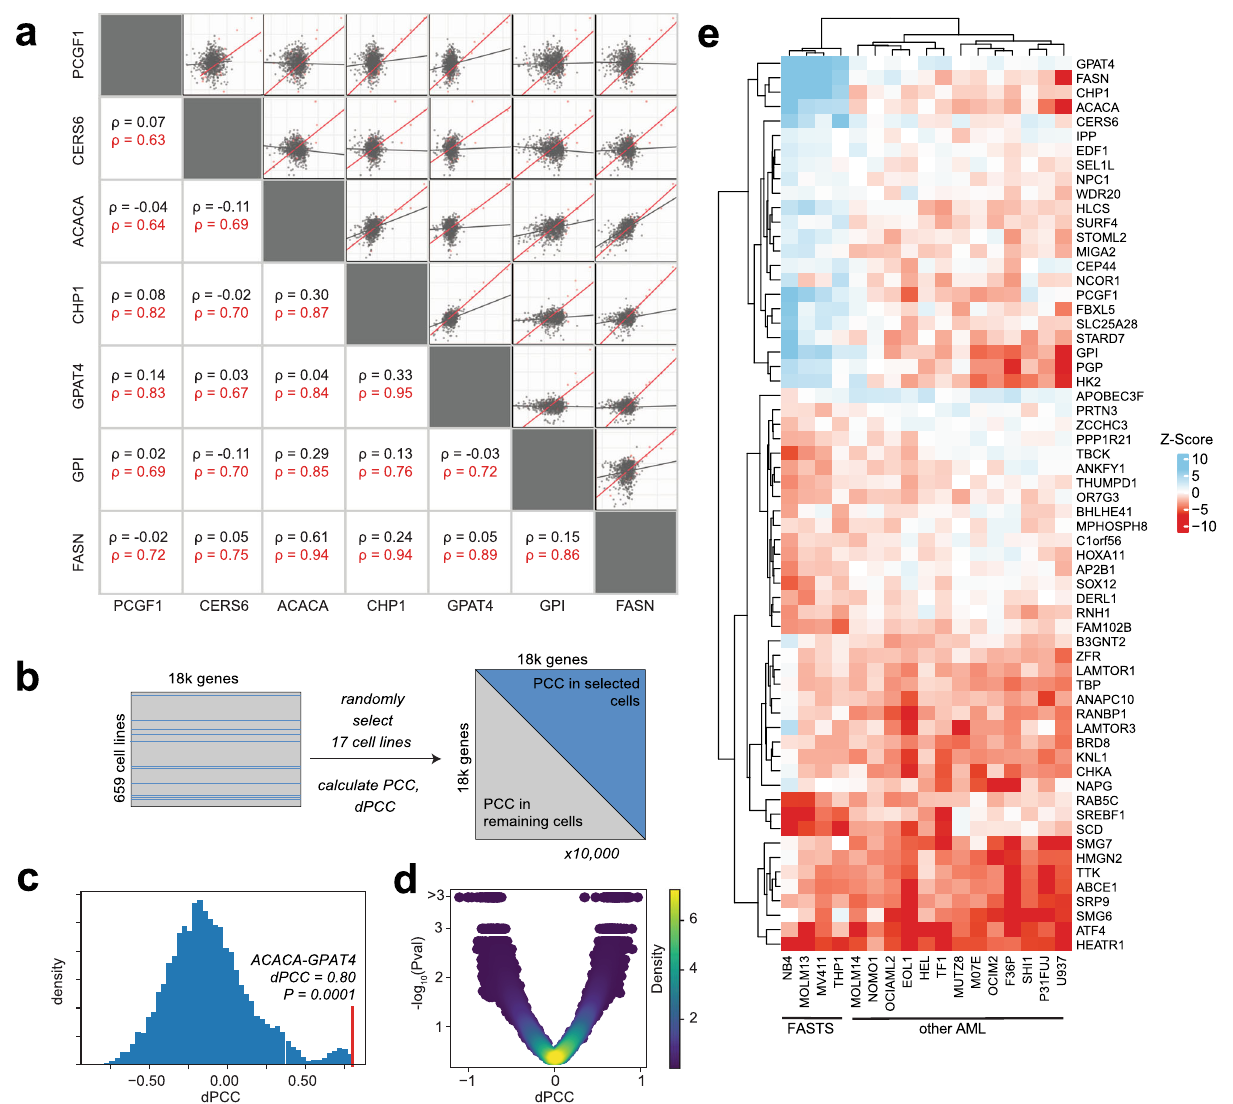
Fig. 3 Differential network analysis of fatty acid synthesis module. a Among genes in the FAS module, Pearson correlation coef fi cients of mixed Z- score pro fi les are substantially higher in AML cells (red) than in other cells (gray). b Signi fi cance testing of differential PCC (dPCC) involves quality fi ltering of Avana data ( n = 659 cell lines, including 17 AML cell lines), building a null distribution by randomly selecting 17 cell lines, and calculating PCC between all gene pairs in the selected cells and the remaining cells. c After 10,000 repeats, a null distribution is generated for each pair, and a P value (permutation test, n = 10,000) is calculated for the observed AML vs. other dPCC. d Volcano plot of dPCC vs. P value for all genes in the Co-PS cluster. e Heatmap of mixed Z- score for 17 AML cell lines in selected genes with high |mixed Z | and high |dPCC | . Clustering of cell lines indicates the putative fatty acid synthesis/tumor suppressor (FASTS) essential phenotypes when these genes are knocked out. The anticorrelated genes, including SCD and SREBF1 , show heigh- tened essentiality in these same cell lines. Together these observed shifts in gene knockout fi tness indicate that this subset of AML cells has a substantial metabolic rewiring. Because these cells share a genetic signature among fatty acid synthesis pathway genes that is consistent with tumor suppressors, we call these cell lines Fatty Acid Synthesis/Tumor Suppressor (FASTS) cells (Fig. 3e).